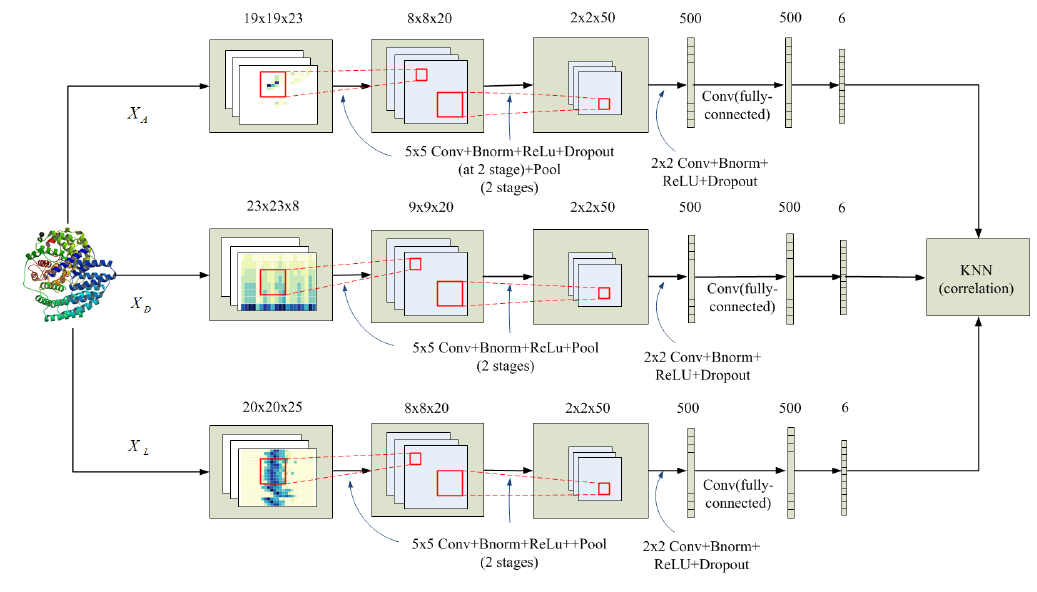
Figure 7. Framework of the